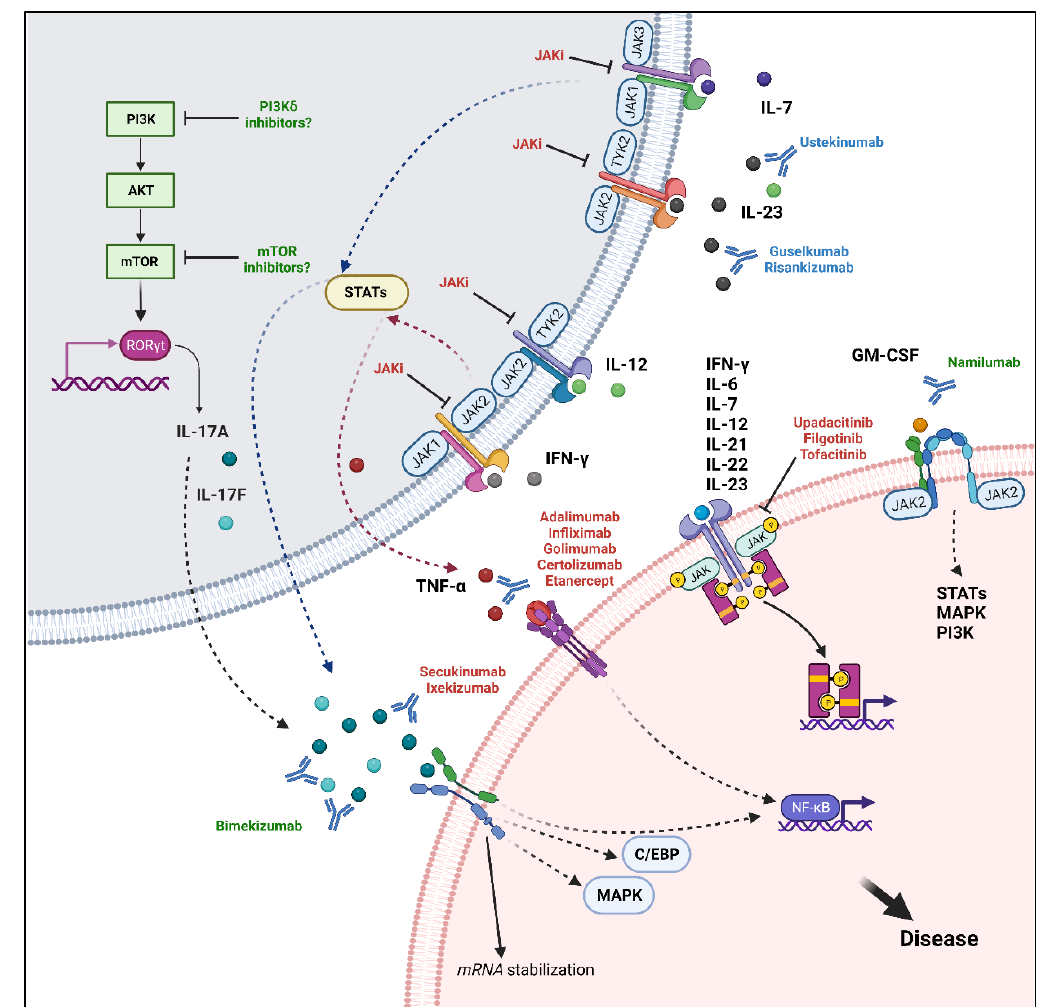
Figure 3. Molecular targets and associated signalling pathways. Current therapeutic targets in